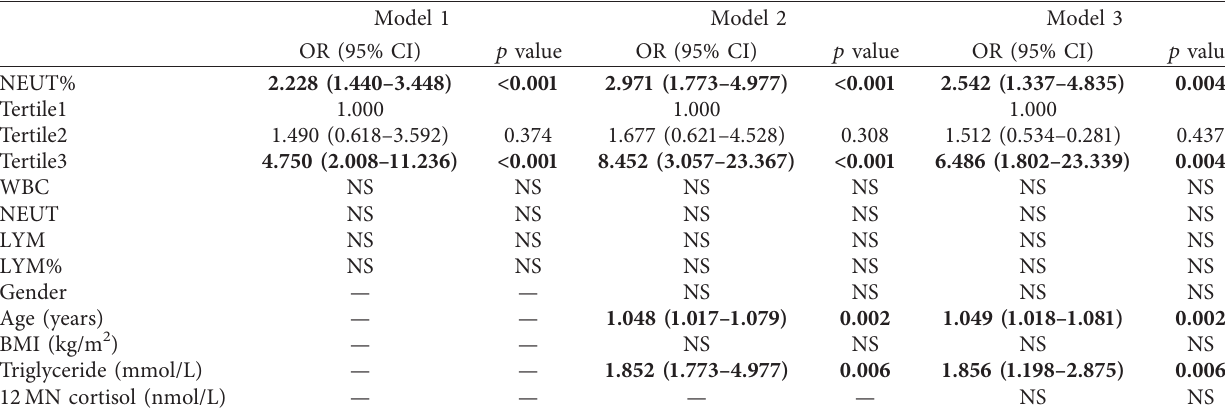
Table 3: Logistic regression analysis used to determine the risk factors for development of